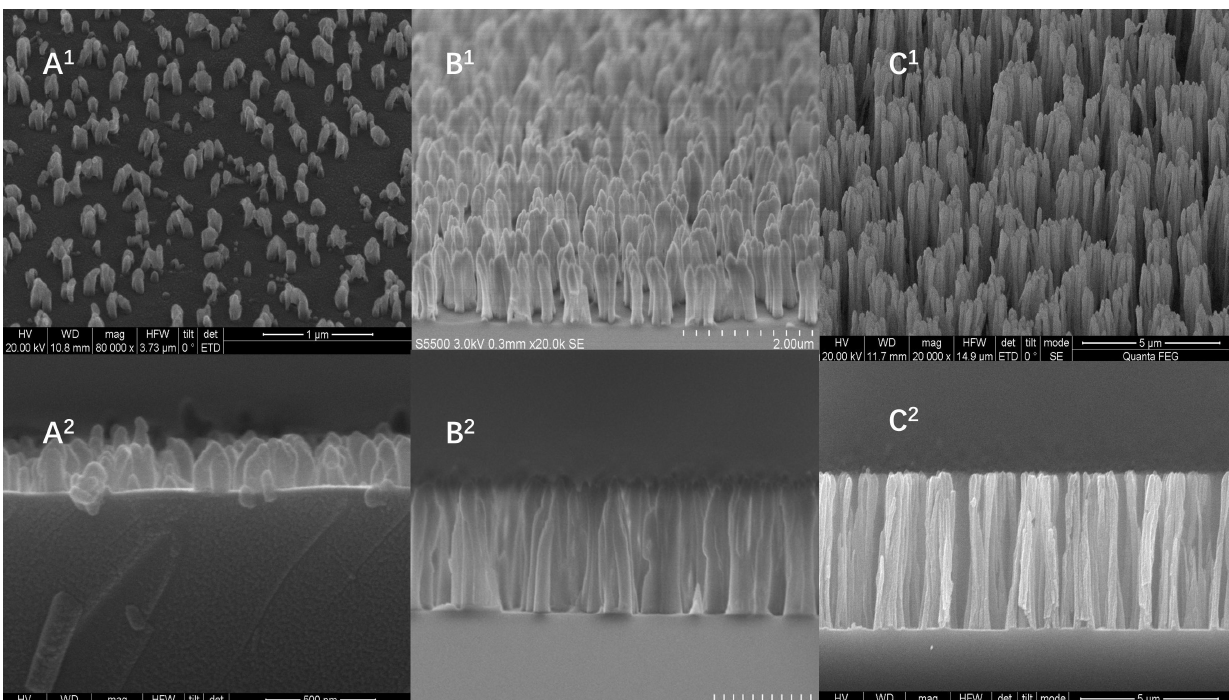
Figure 5. SEM photographs of nanoforest structures (1,2 are the same nanoforest at a different angle).